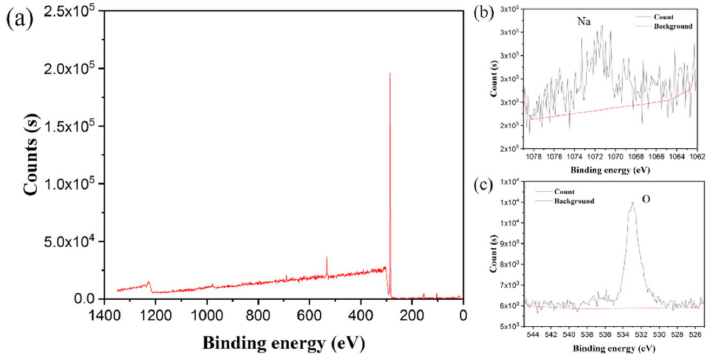
Figure 15. XPS spectrum of Specimen 3 before water absorption: the whole scanning region ( a ); the region of Na ( b ) and the region of O ( c ).